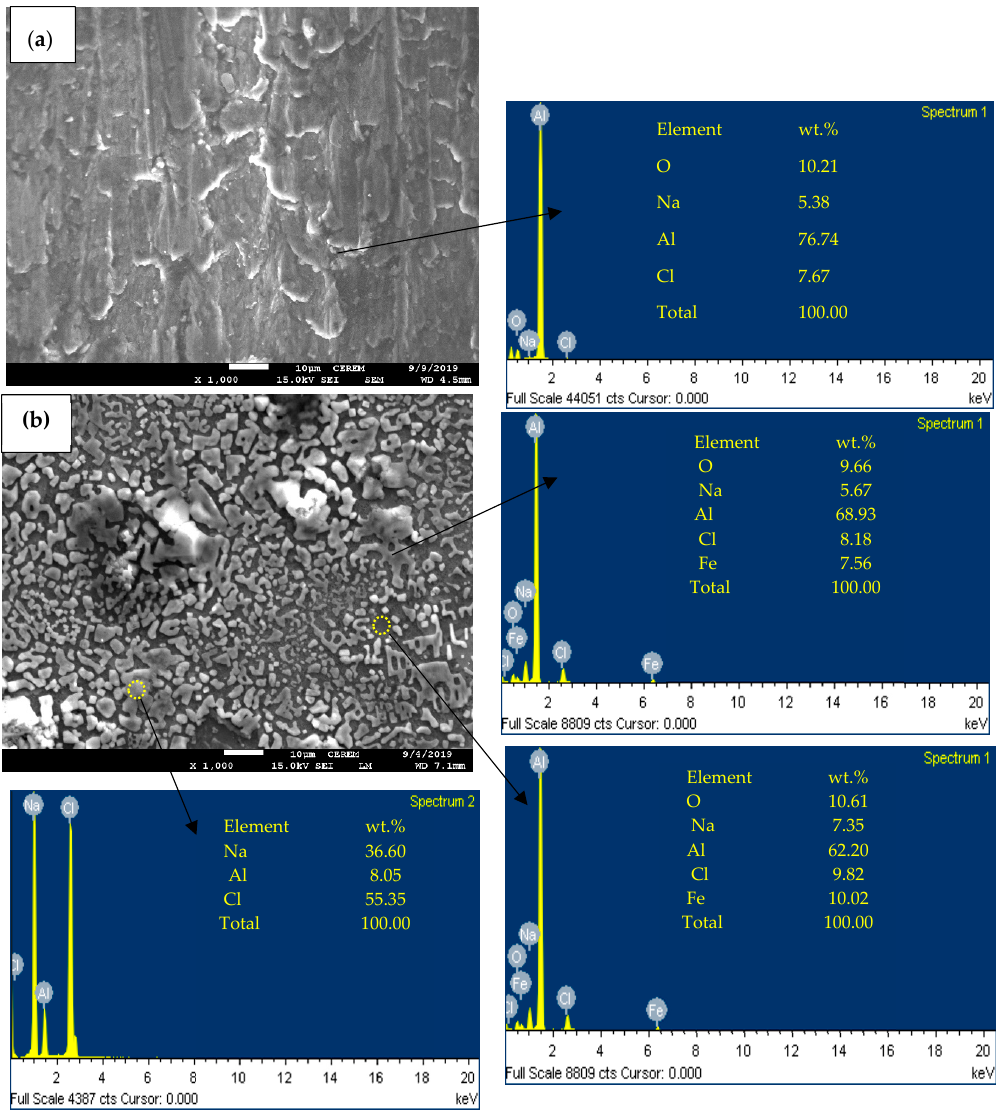
Figure 11. Field emission scanning electron microscope (FESEM) micrographs and EDS profile analysis obtained for ( a ) pure Al and ( b ) Al-10 wt.% Fe alloys after one hour immersion in 3.5% NaCl at room temperature.